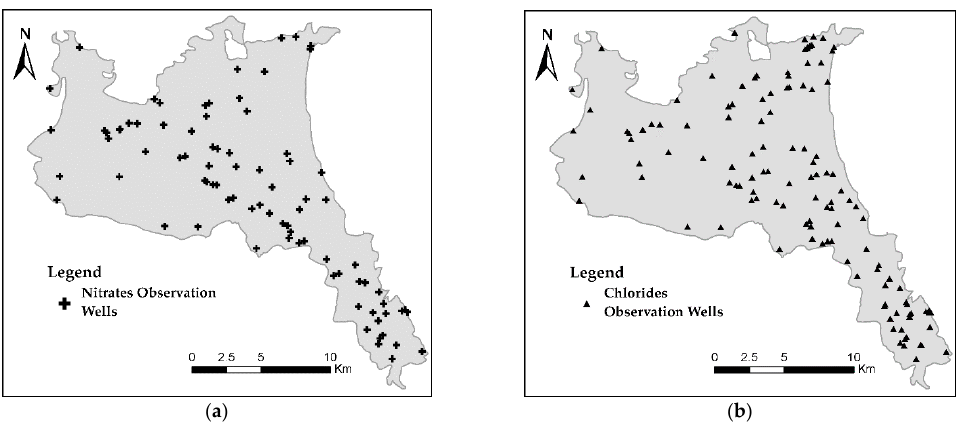
Figure 5. ( a ) Locations of nitrates observation wells and ( b ) locations of chlorides observation